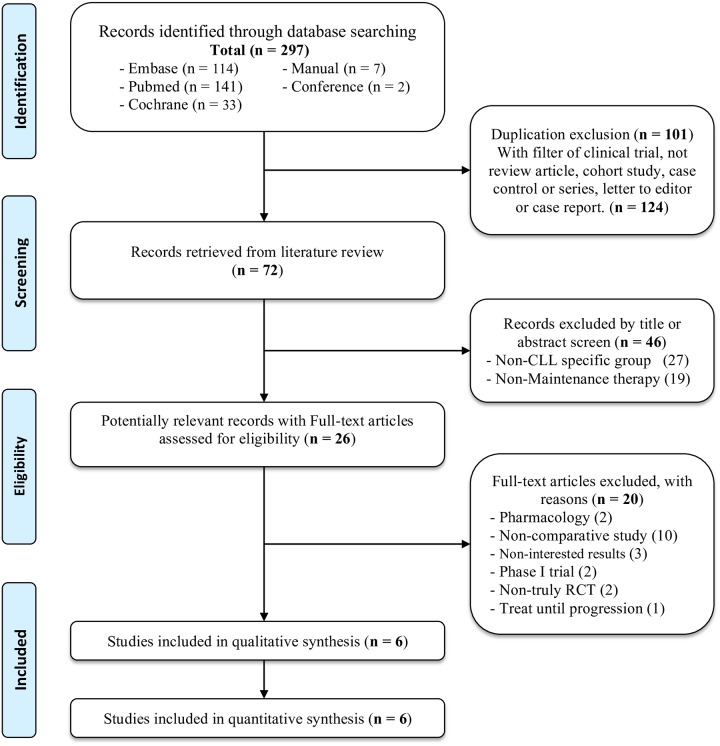
PRISMA flowchart of network meta-analysis.